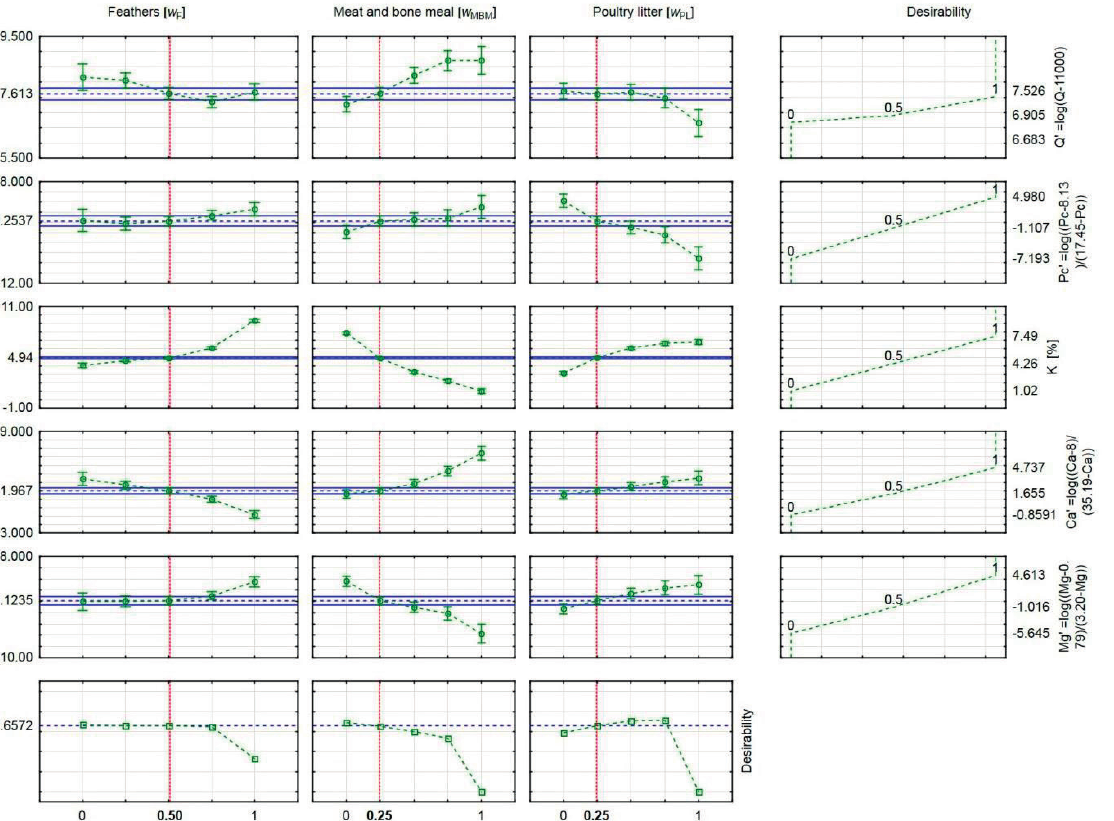
Fig. 2. Approximation profile with the utility function for the mixture F:MBM:PL –